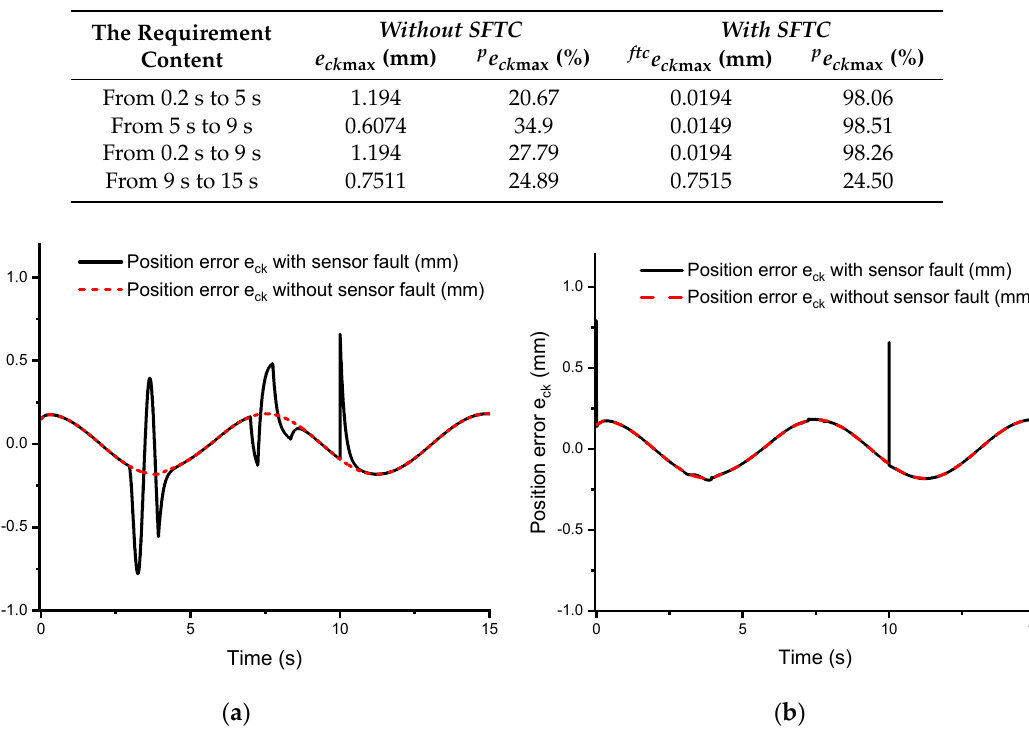
e for the case without disturbance ck